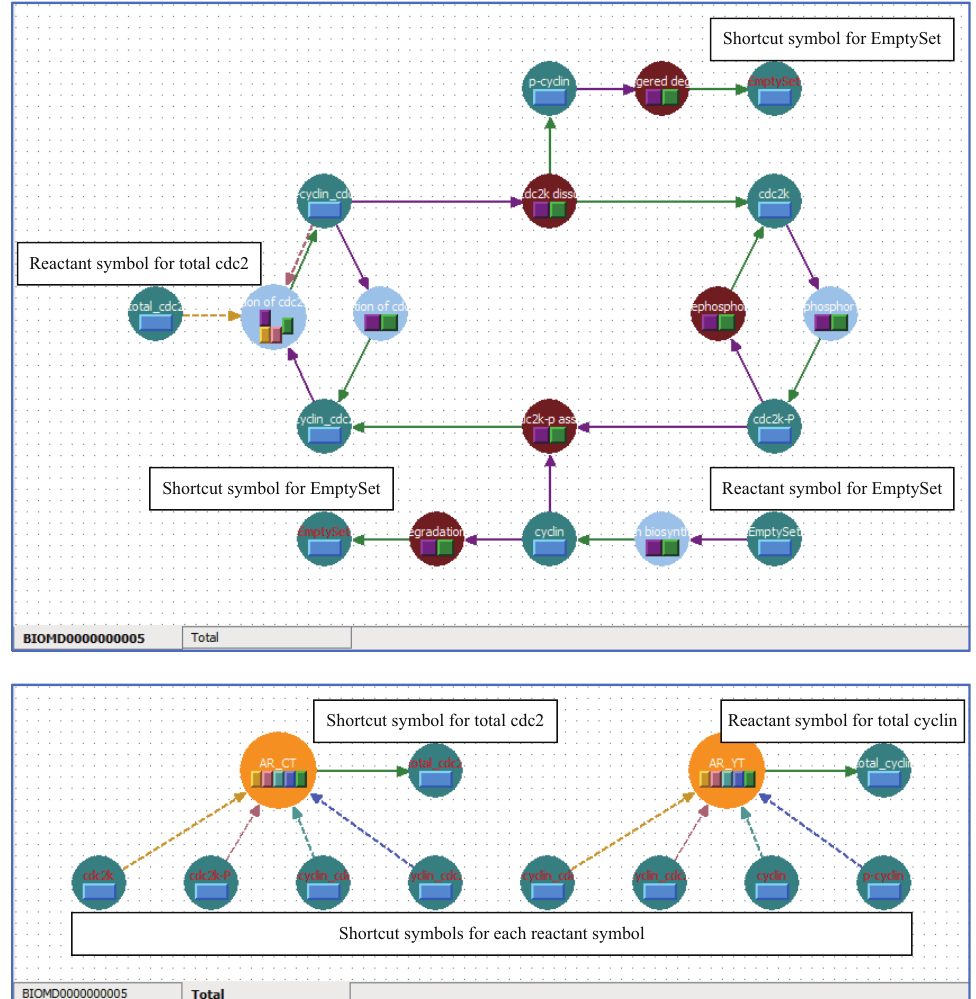
Figure 11. Screenshot after rearranging the symbols. Users can divide the SBML models into layers according to their specific roles, connect the layers, and analyze them as a single integrated model by using the shortcut